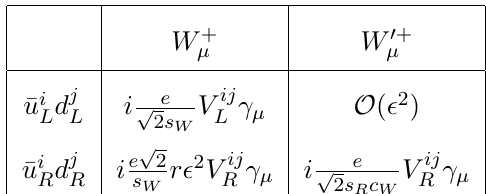
Table 6 . Couplings of charged gauge bosons to quarks (the adaptation to leptons is straightfor- ward).